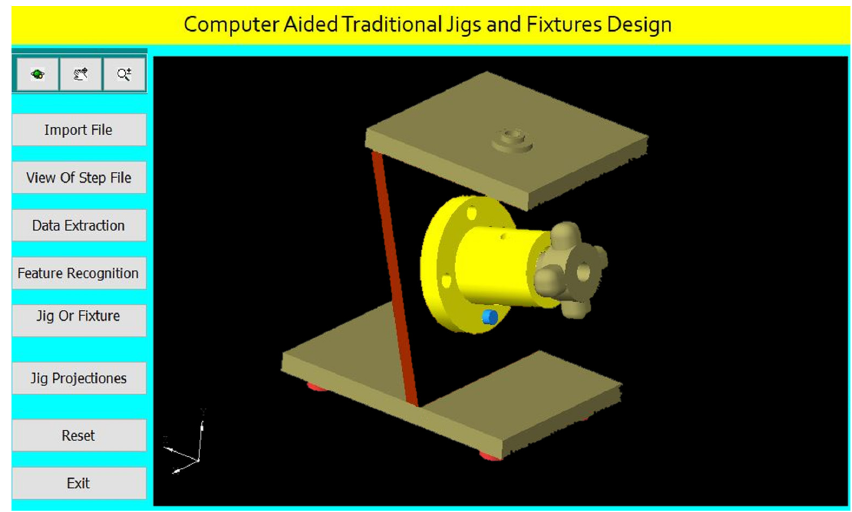
Figure 57. Computer-aided design of a jig for the cylindrical part.